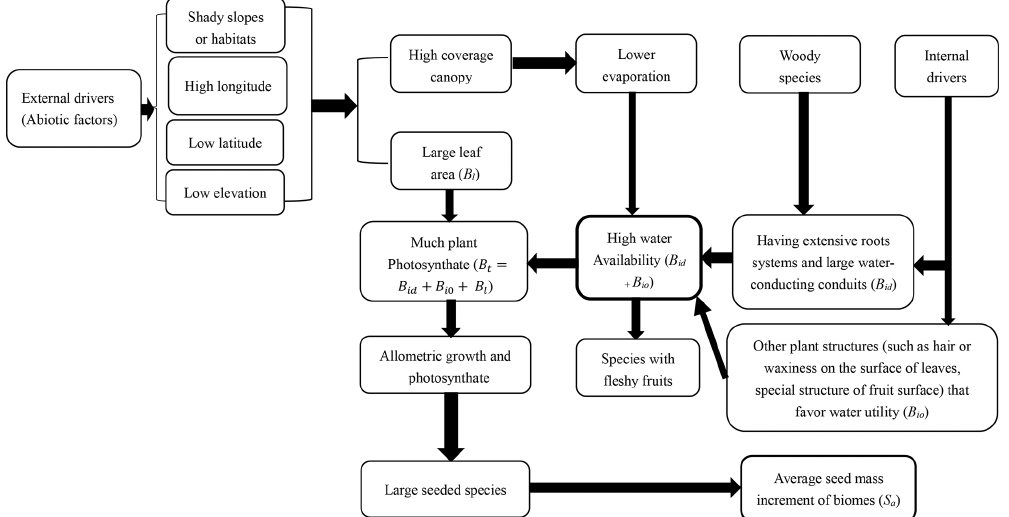
Figure 6. Mechanistic frameworks of large seeded species formation and corresponding increment process of community average seed